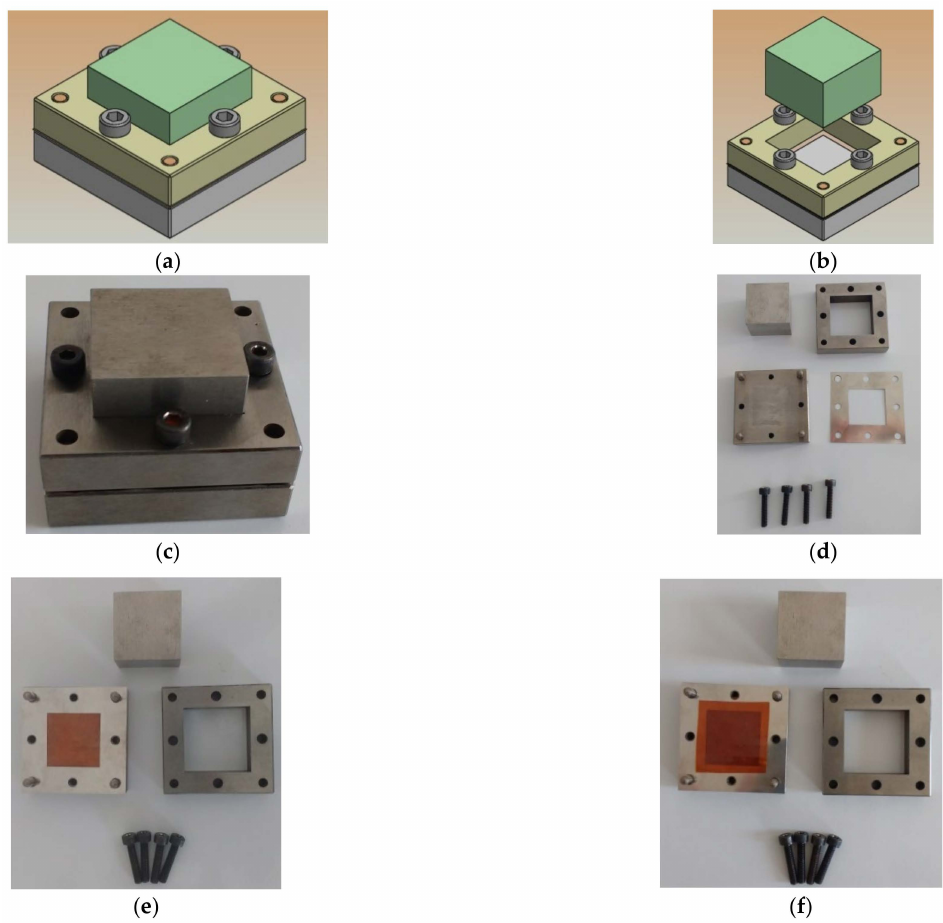
Figure 2. Mold used for the manufacturing process of flexible composite films: ( a ) and ( b ) the design; ( c ) assembled mold; ( d ) mold parts; ( e ) and ( f ) Kapton ® films used during the process.